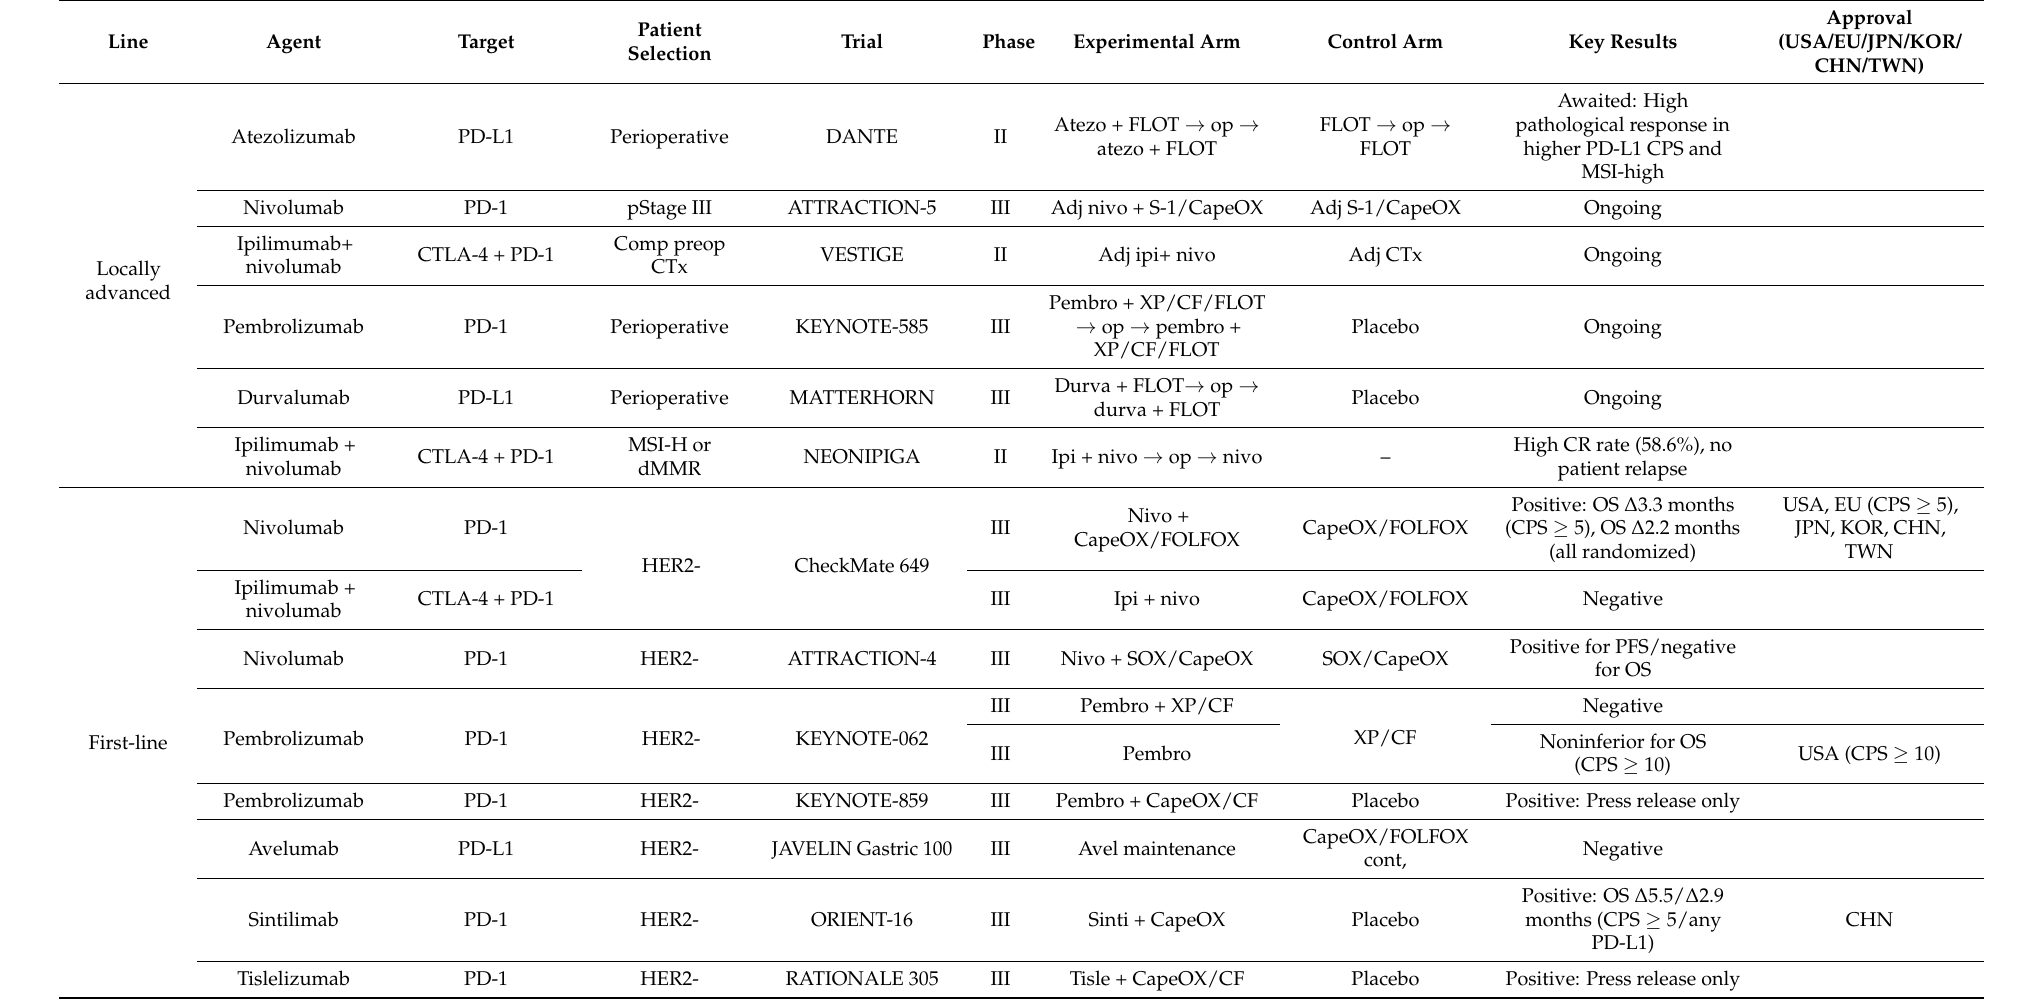
Table 2. Overview of clinical trials including immune checkpoint